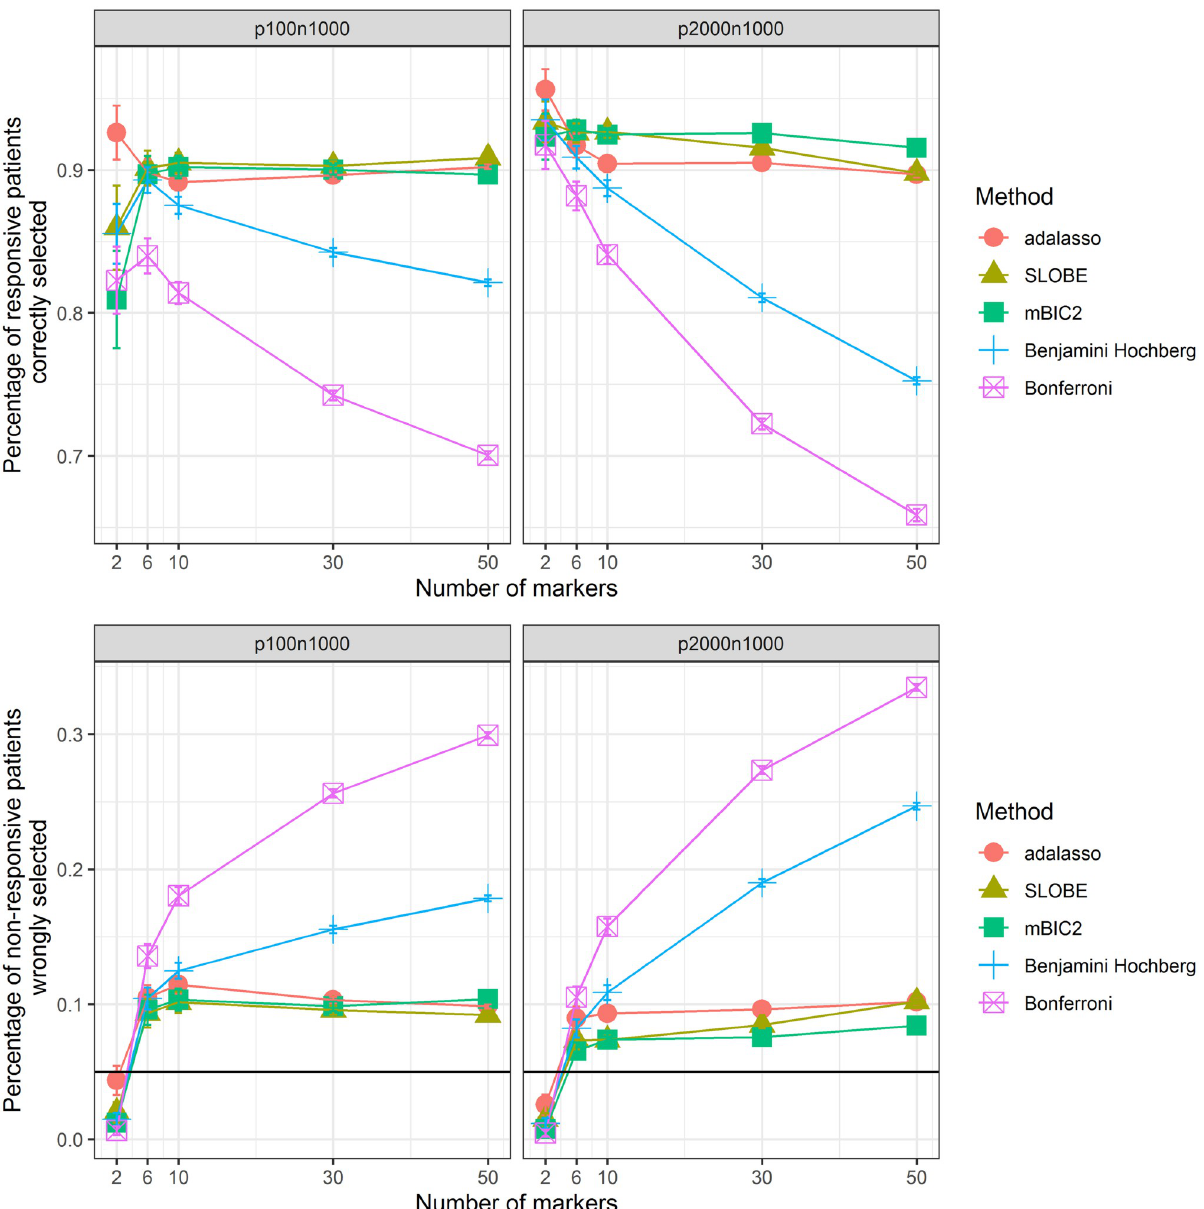
Fig 3. Identification of responders and non-responders. First the percentage of responsive patients (true R ( X ) > 0) identified by different methods (estimated R ( X ) > 0) as a function of the number of causal variants k for two different simulation scenarios ( p < n and p > n ). Then the percentage of non-responsive patients (true R ( X ) < 0) wrongly selected by different methods (estimated R ( X ) > 0).